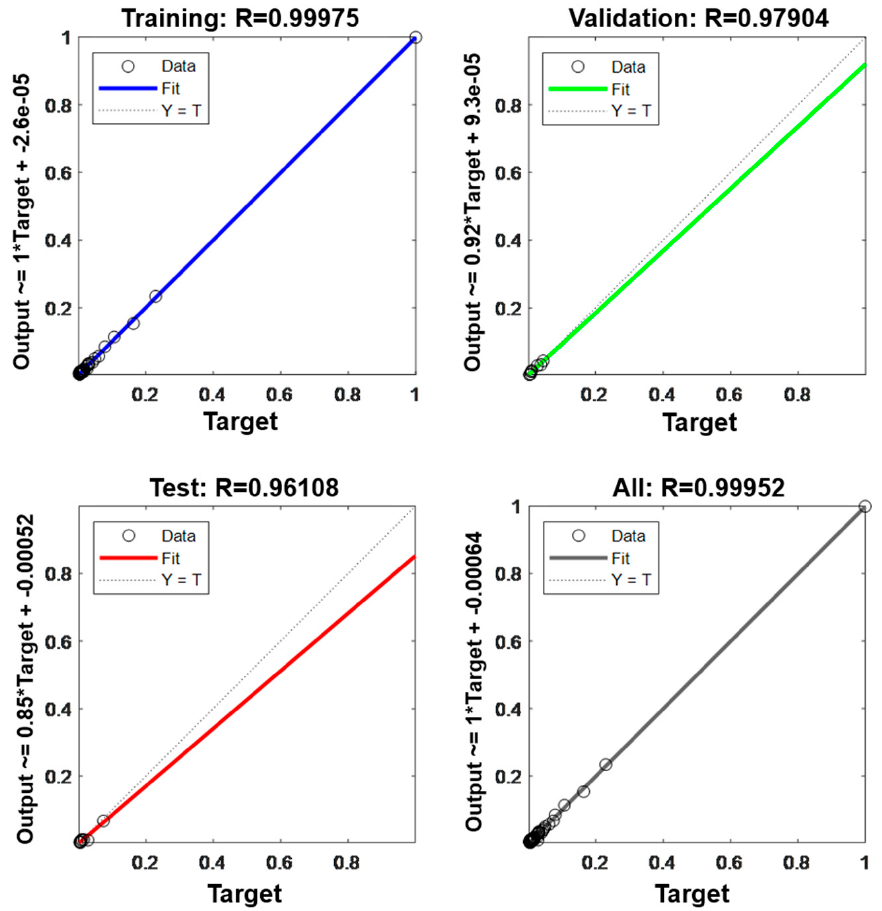
Figure 3. The correlation coefficient R for training analysis of an ANN with three variables in the input layer, and two hidden layers with eight neurons each. Table 5. ANN architectures and their performance for the simulation step .